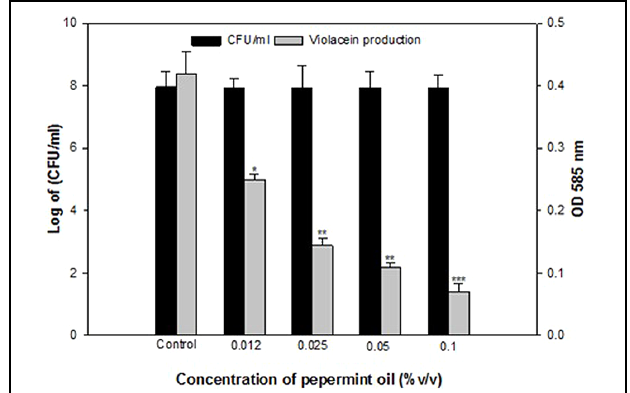
FIGURE 1 | Quantitative assessment of violacein inhibition in CVO26 by sub-MICs of peppermint oil (PMO). All of the data are presented as mean ± SD. Significance at ∗ p ≤ 0.05, significance at ∗∗ p ≤ 0.005, significance at ∗∗∗ p ≤